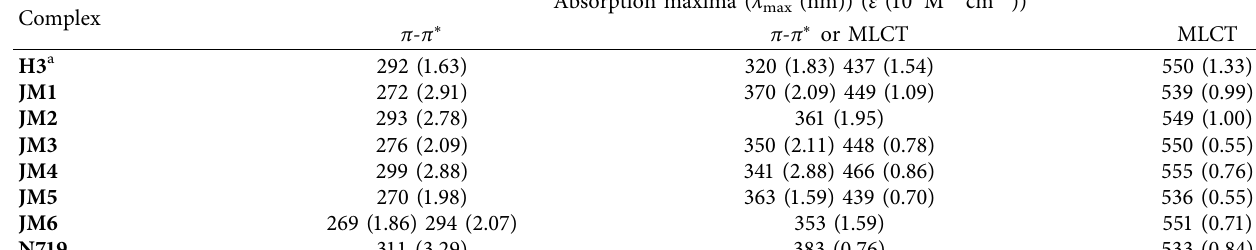
Table 1: Absorption maxima ( λ max ) and molar absorption coefficients ( ε ) of JM1 – JM6 and N719 (standard solution in DMSO; 1 Complex